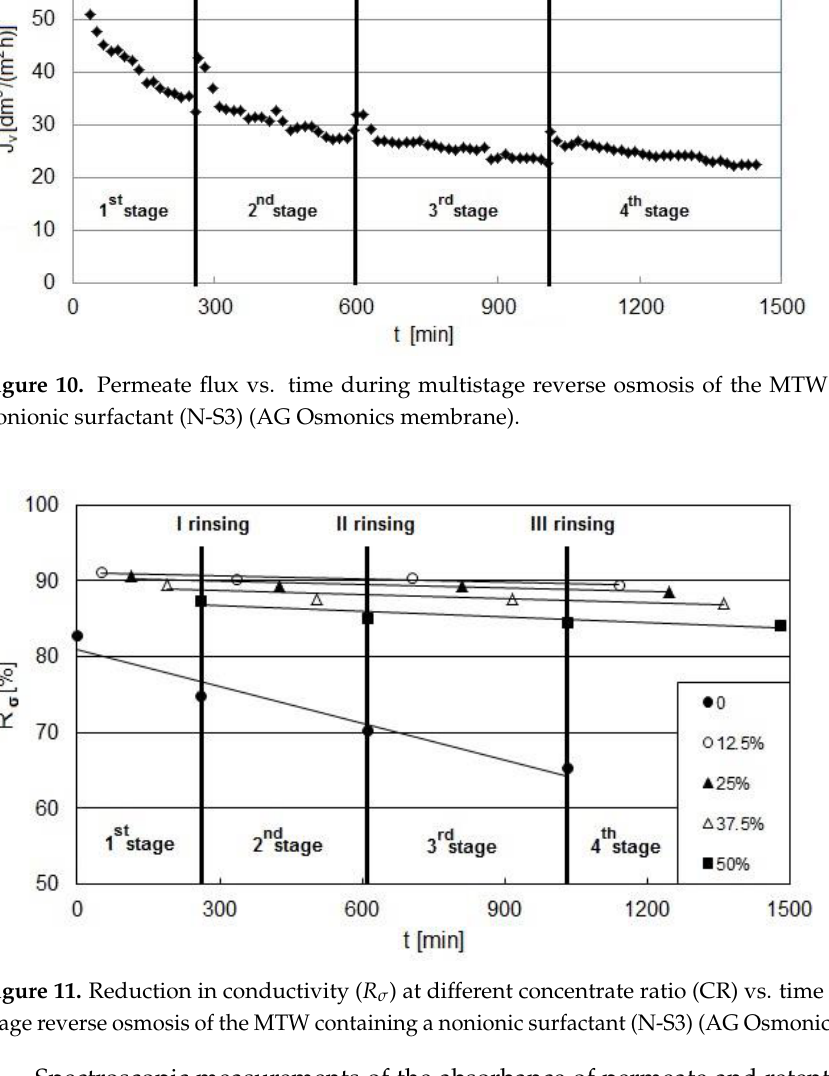
Table 5. Color difference Δ E ab of dyed samples with a color intensity of 0.1% in pure water and treated MTW: knitted fabric 100% CO.